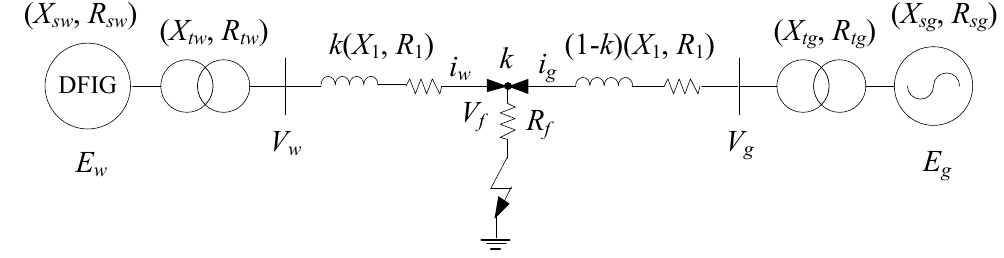
Figure 4. The simplified distributed generation system.